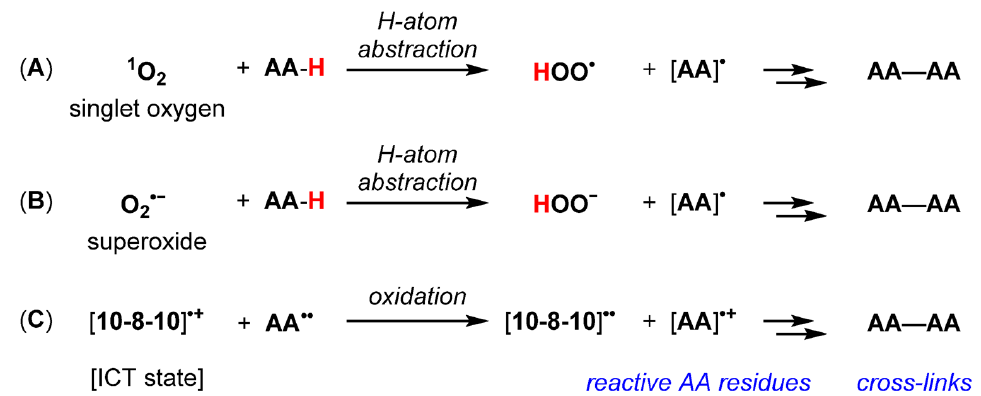
Figure 3. ( A – C )Proposed 10-8-10 Dimer promoted reactions to generate oxidized amino acids [AA]* intermediates and subsequent crosslinks (AA—AA).